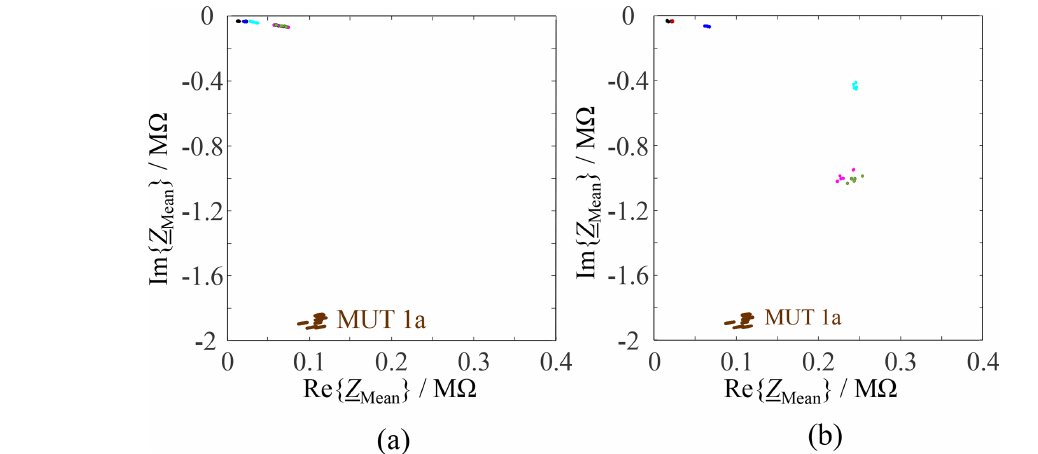
Figure 11. “Mean” feature measured in the field. (a) Batch 1. (b) Batch